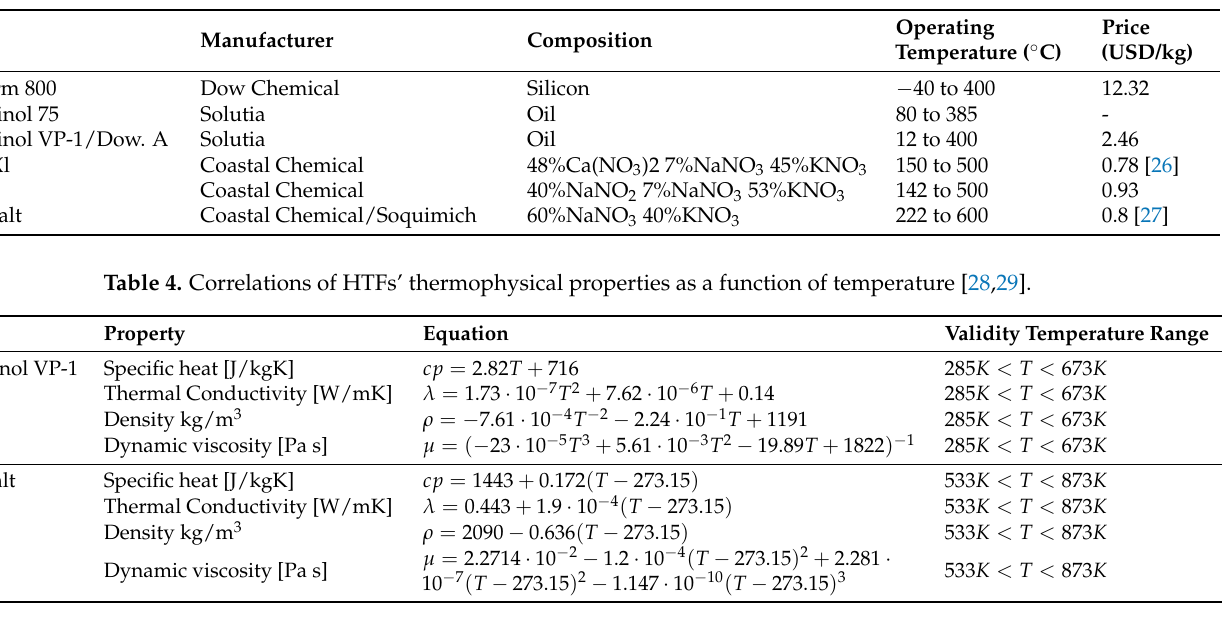
Table 3. Main heat transfer fluids (HTFs) available commercially.